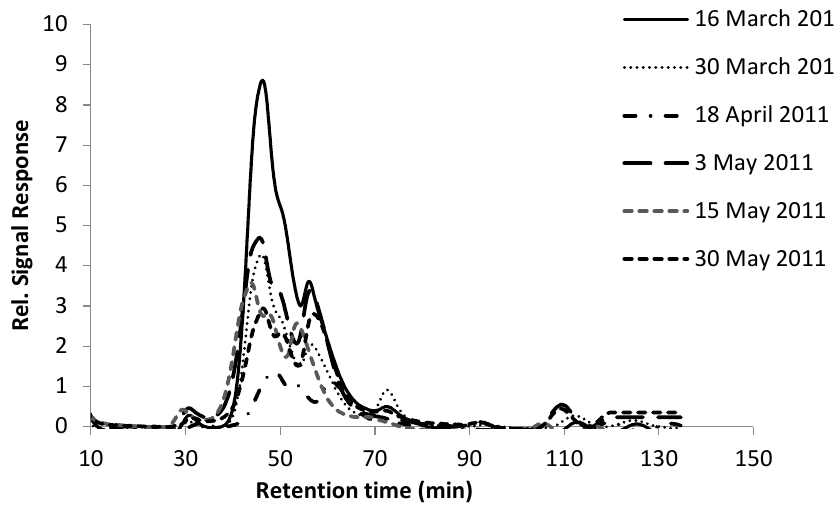
Figure 3. LC-OCD chromatogram of stormwater samples using organic carbon detector.